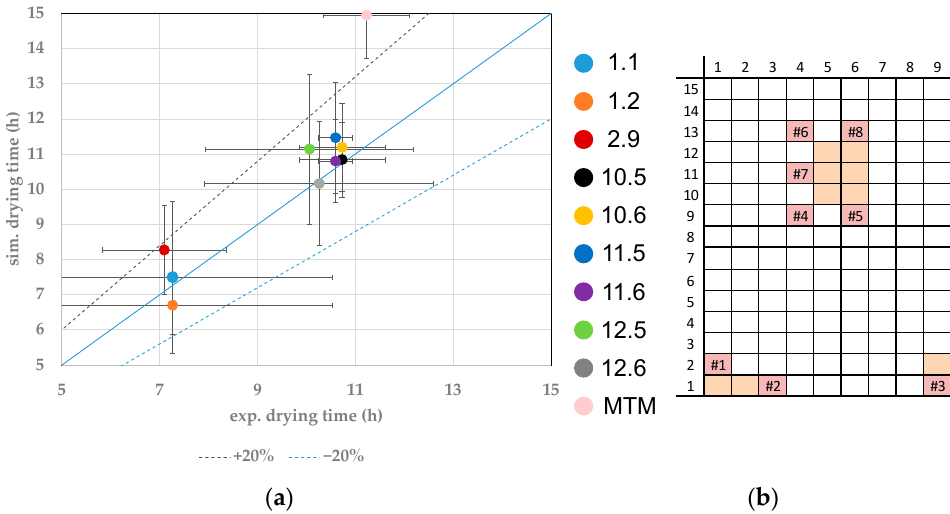
Figure 10. ( a ) Parity plot between simulated and experimental primary drying endpoints for distinct vials at the CP. ( b ) Color legend and vial position (orange: probed vials, pink: WTMplus sensor position and WTMplus number).